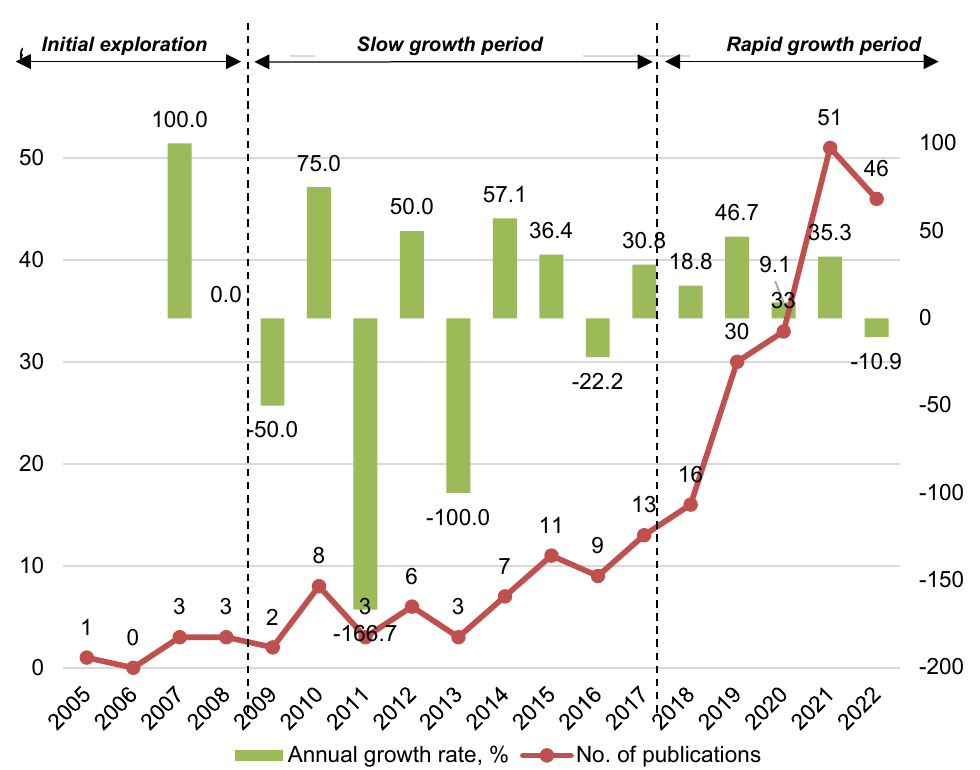
Fig. 3. Dynamic of publication activity, 2005–2022 (up to 7 September). Source: developed by the